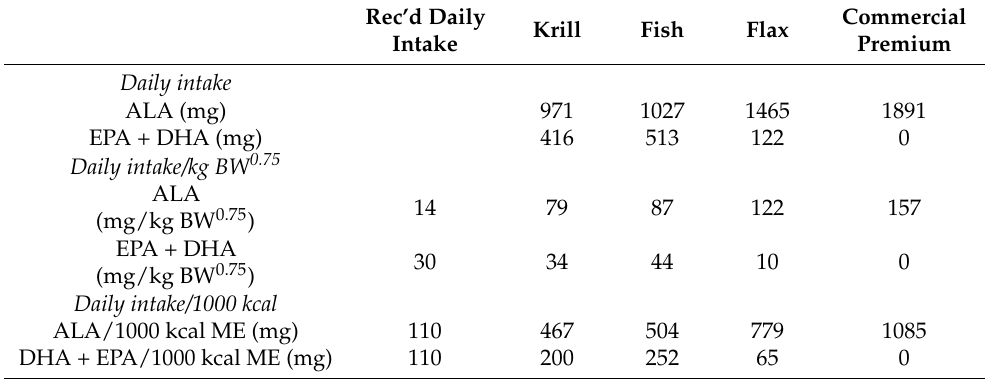
Table 5. Recommended daily intake and daily metabolic bodyweight (BW 0.75 ) intake of ALA and EPA/DHA in the treatment diets in comparison to the commercial premium diet [10].